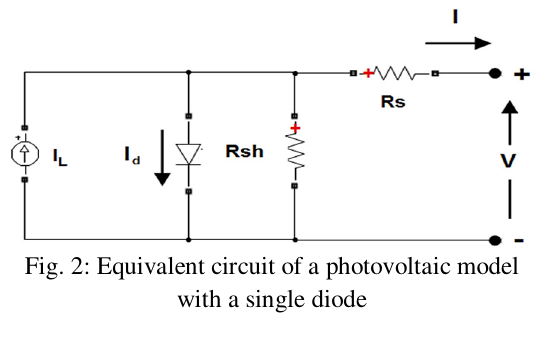
Fig. 2: Equivalent circuit of a photovoltaic model with a single